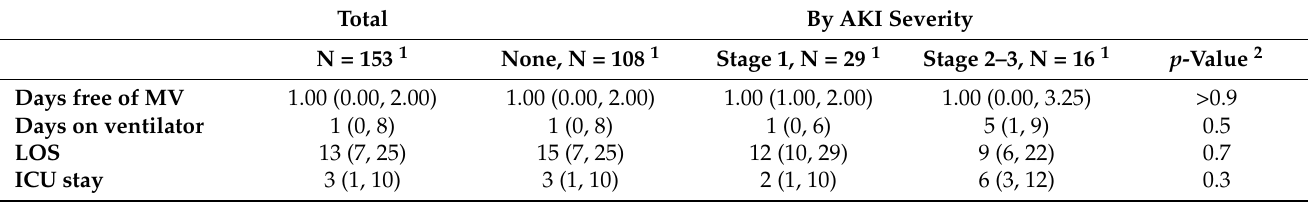
Table 5. ICU stay variables, according to severity of AKI.